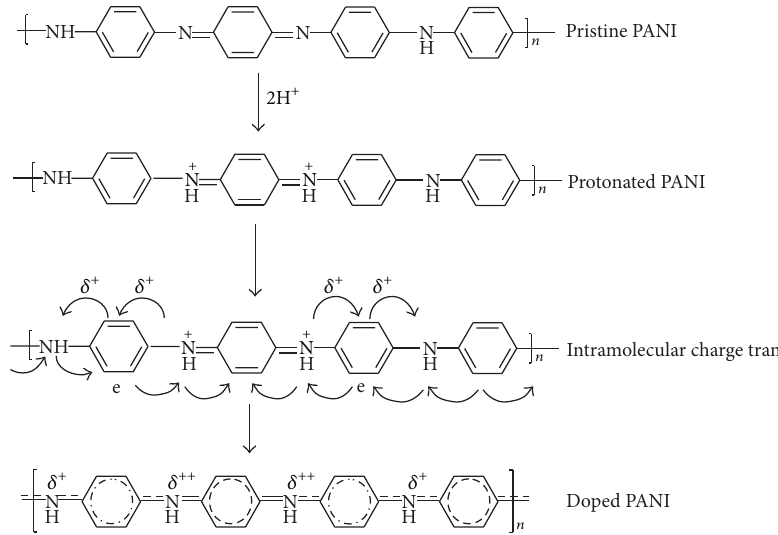
Figure 1: The doping mechanism of PANI.